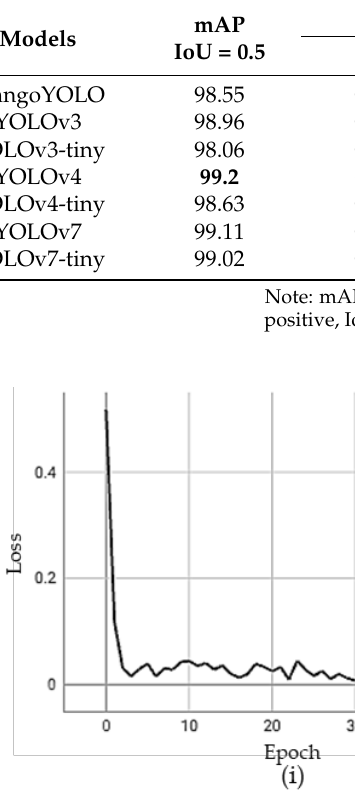
Figure 11. Loss charts for training of the Mask R-CNN model; ( i ) bounding box loss; ( ii ) mask loss. Table 5. Mean average precisions (mAP) of trained Mask R-CNN models. Charts were generated by Tensorboard.